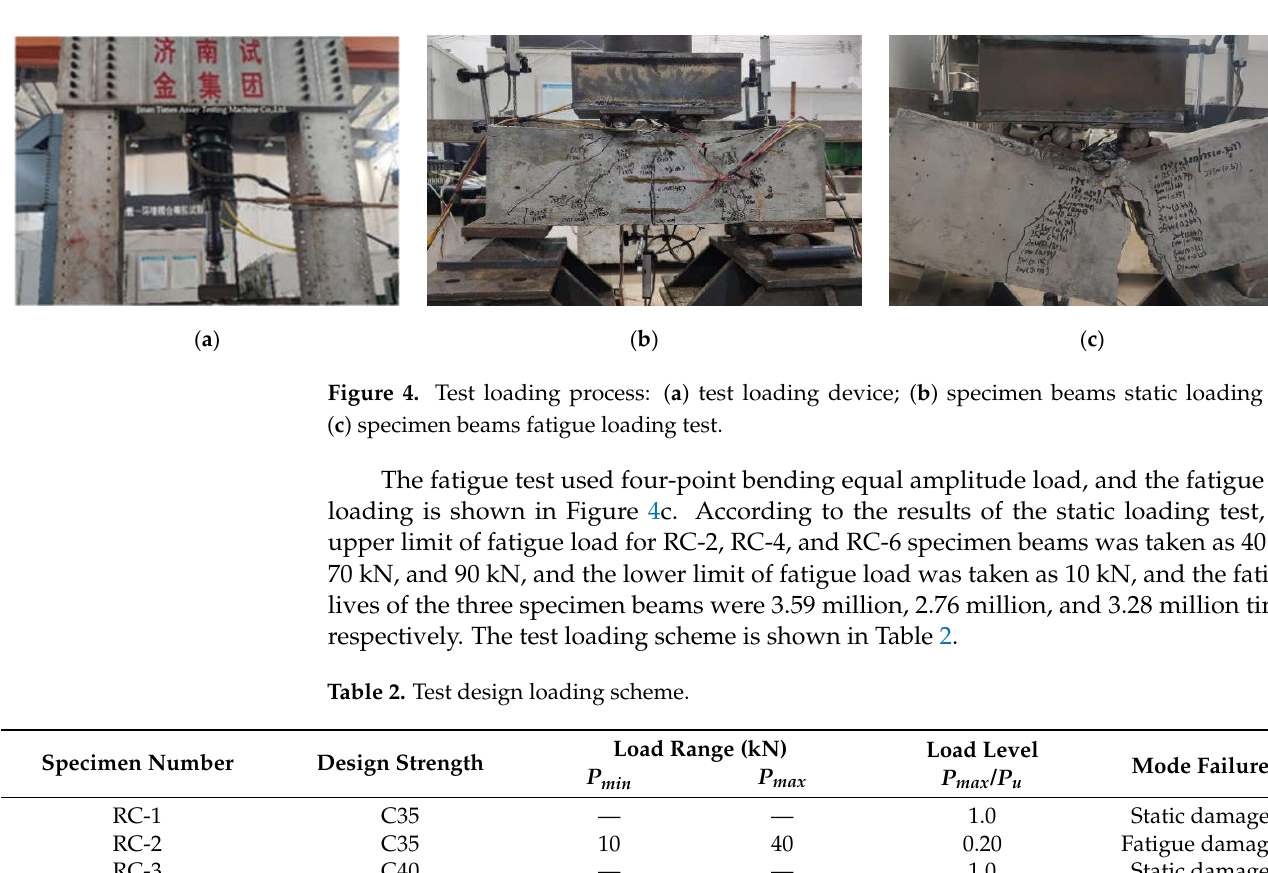
Table 1. Mixture ratio and type of concrete. Design strength